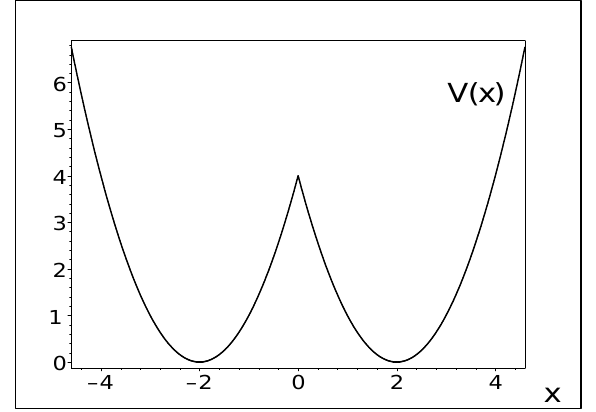
Figure 1. Double-well shape of potential (2) at positive d =